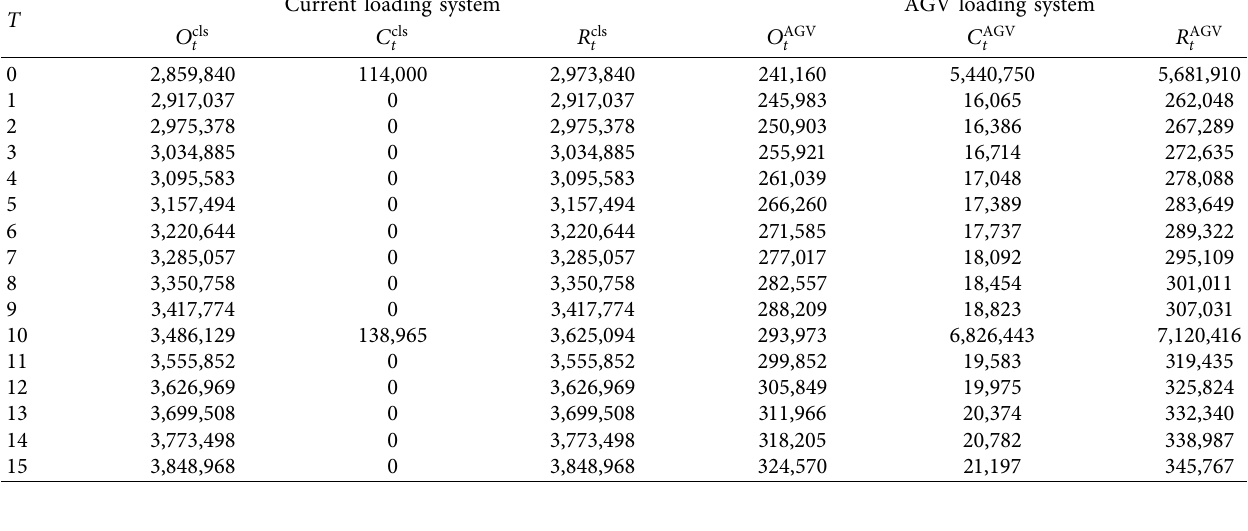
Table 5: Cash flows for the AGV and current loading systems. These cash flows were calculated using equations (5)–(13) in euros ( € ). T